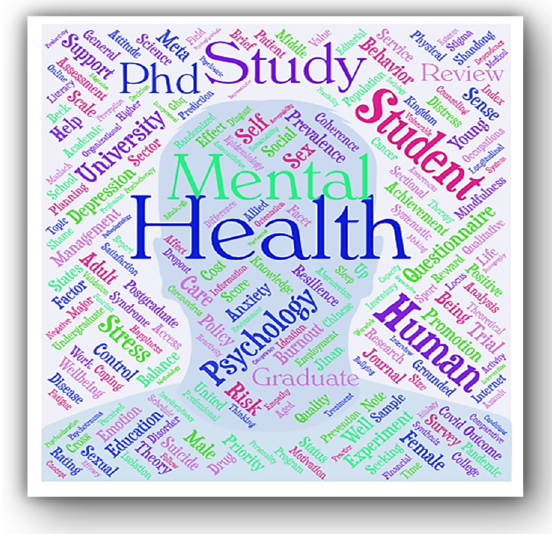
Figure 8. Authors’ Most Frequent Keywords.